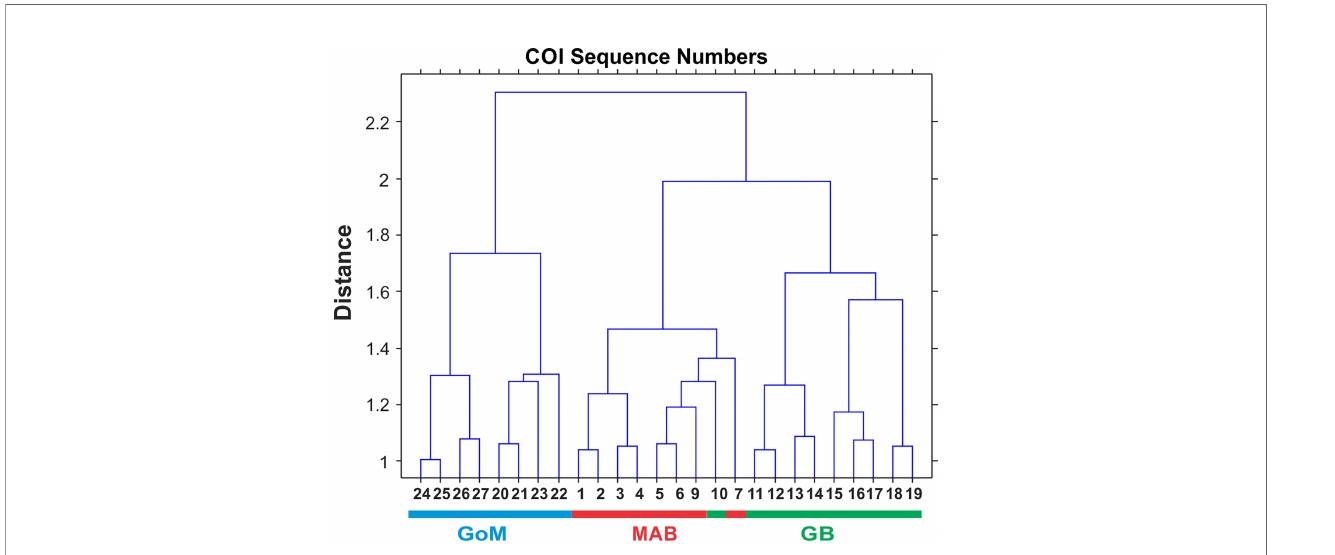
FIGURE 8 | Bray-Curtis similarity index cluster diagram for zooplankton samples collected throughout EcoMon regions based COI sequence numbers for 23 identi fi ed species with totals >1000 COI sequence numbers (see Table 2 ). Regions are indicated as Mid-Atlantic Bight (MAB), Georges Bank (GB), Gulf of Maine (GoM).